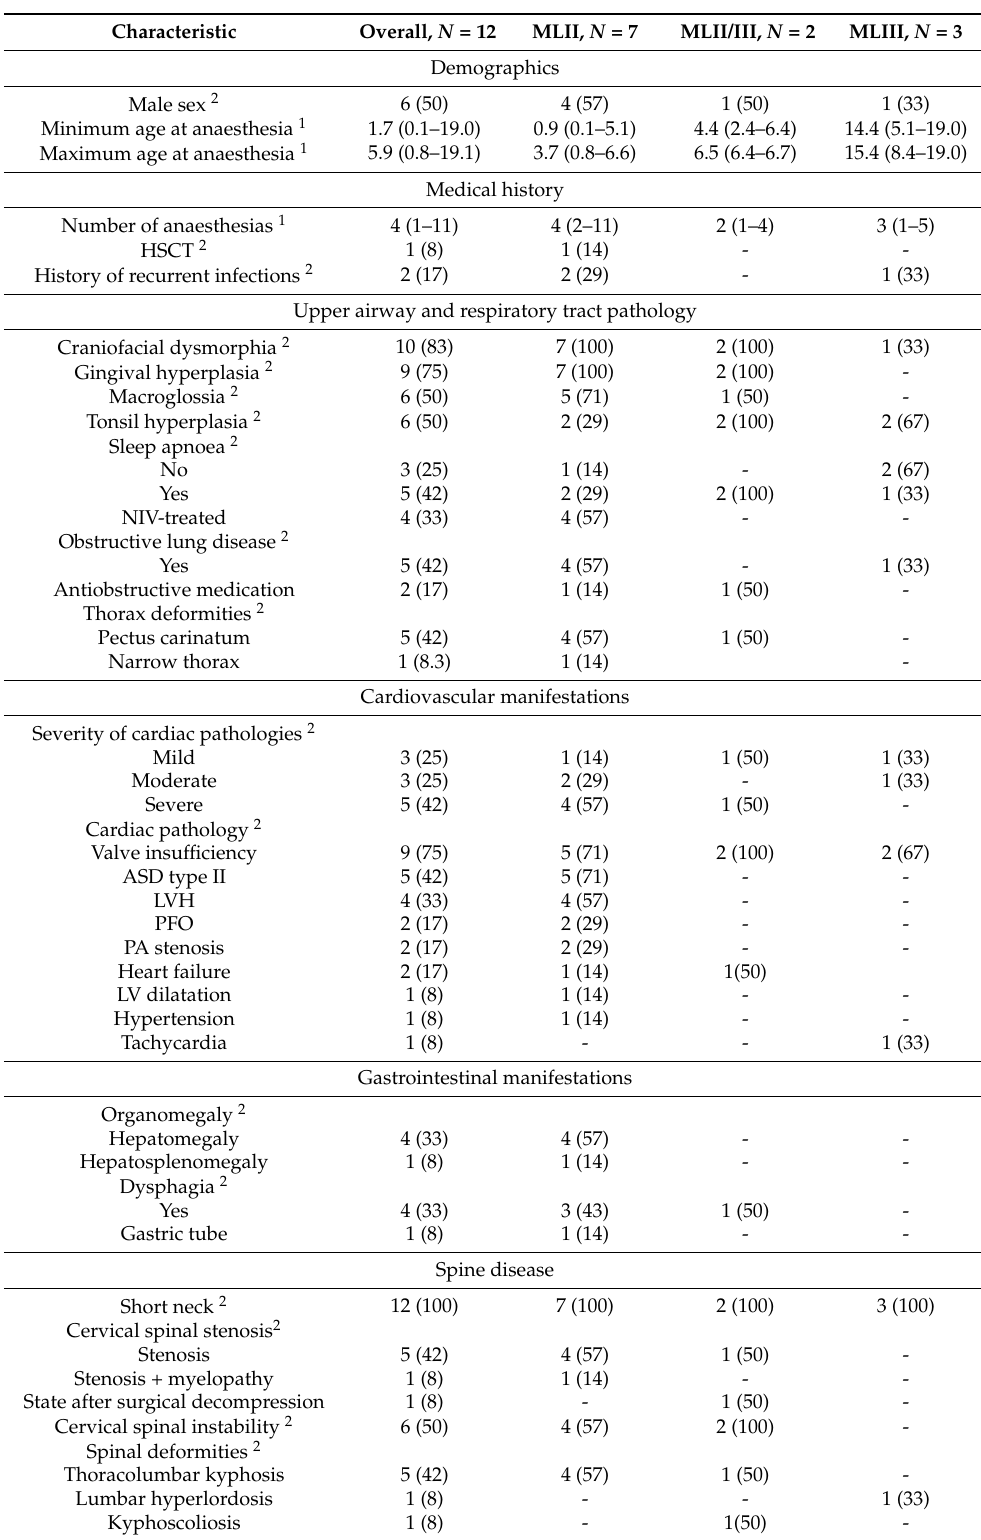
Table 1. Characteristics and anaesthesia-relevant symptoms of patients with